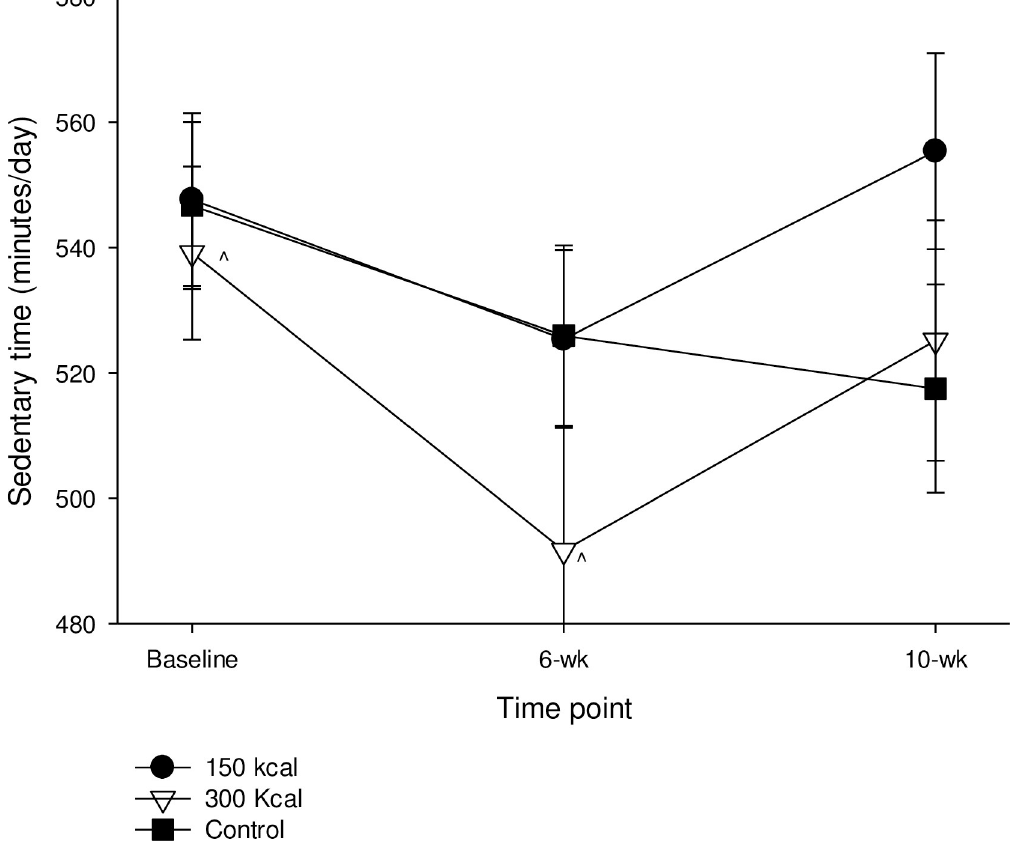
Fig 3. Time spent in sedentary activity assessed via accelerometry from baseline to post (6-week) and at 4-week follow-up. ^ indicates within groups change across time points p < 0.05. Values are means ± SE.